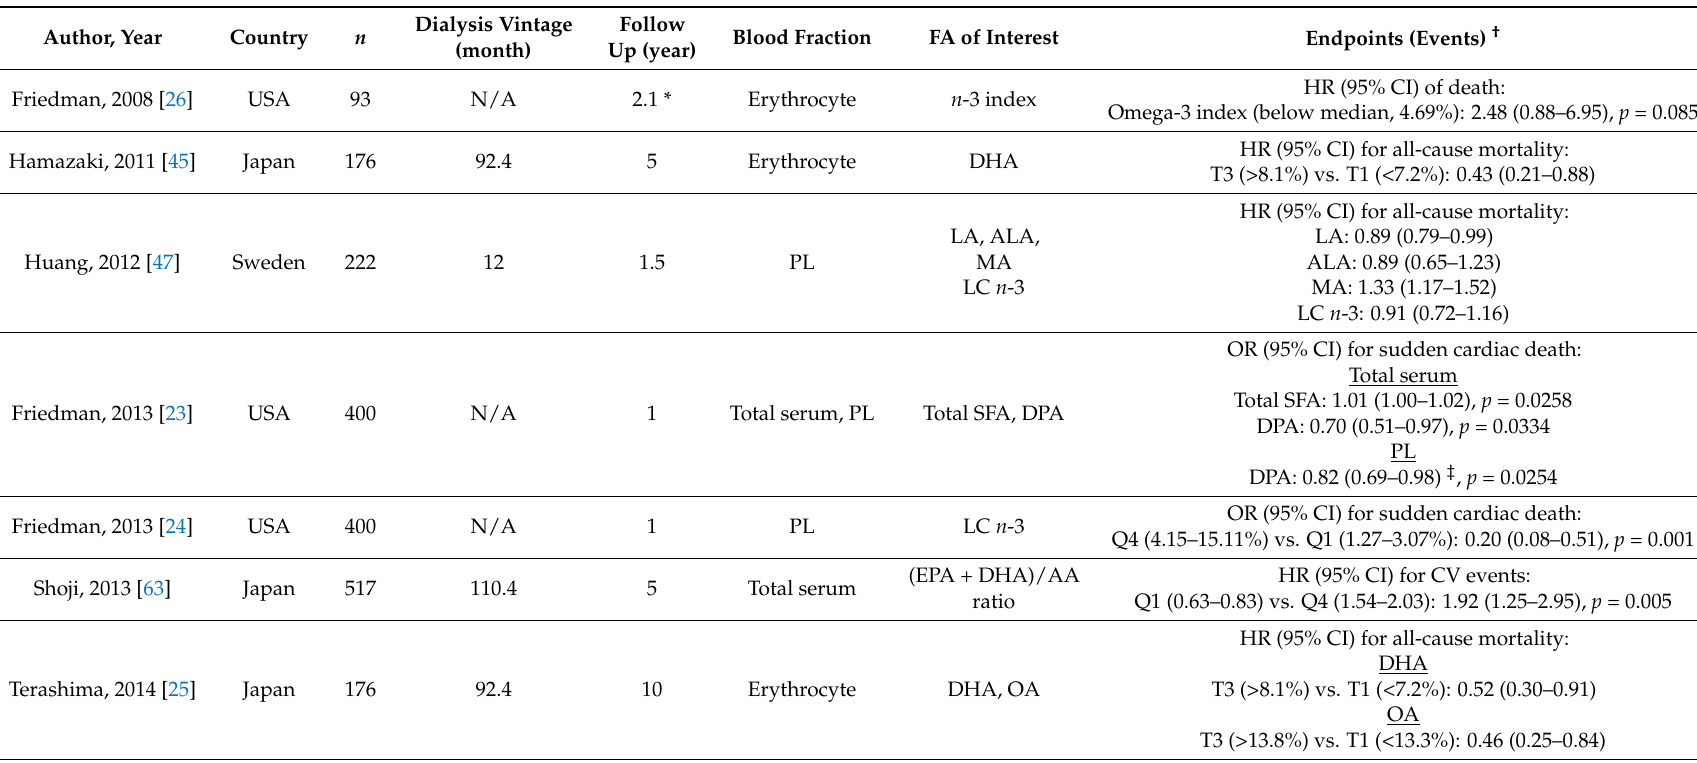
Table 4. Studies with blood fatty acid status predicting clinical